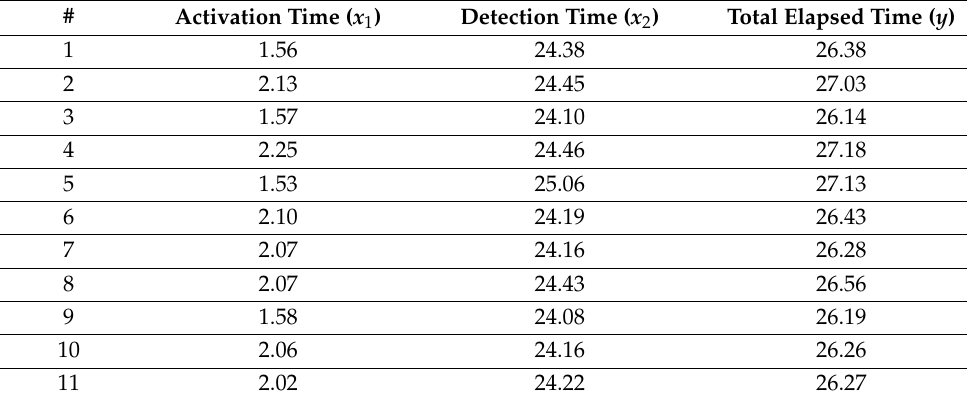
Table 1. Experimental Data for the Operational Time.